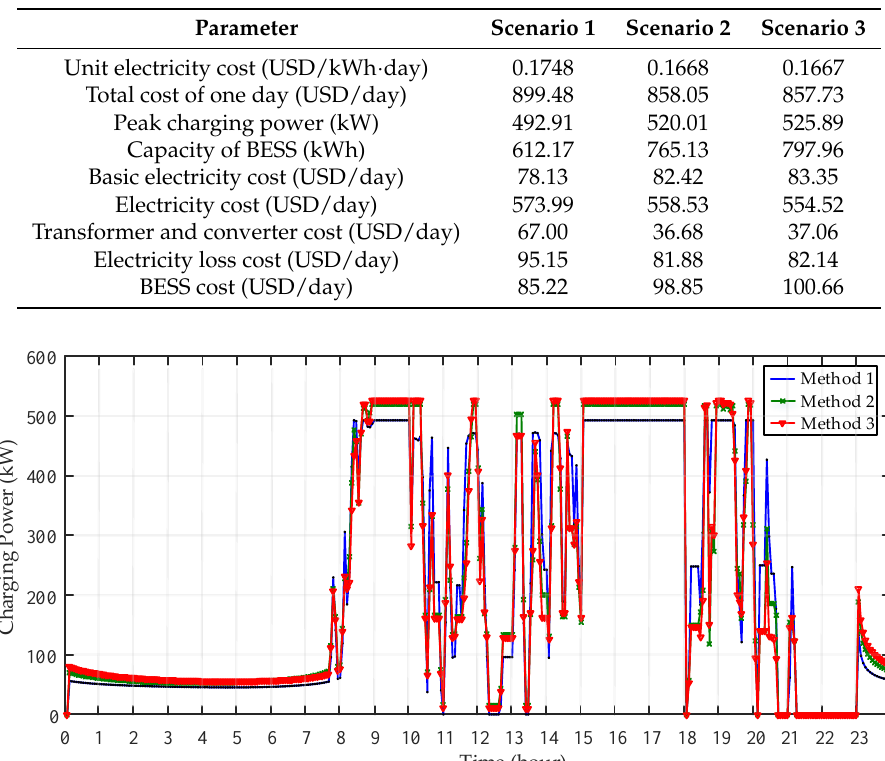
Table 4. Results of three BESS configuration scenarios.